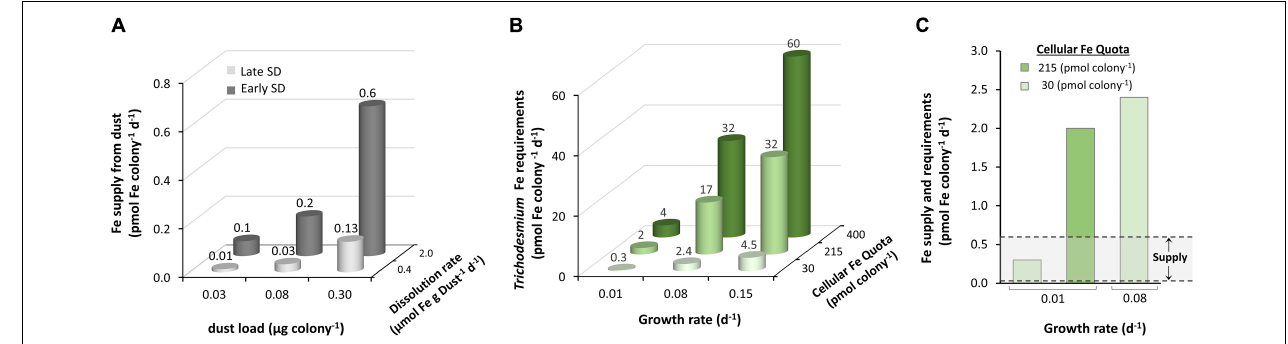
FIGURE 8 | Trichodesmium’s Fe demand versus Fe supply from dust. (A) The supply of dissolved Fe from dust particles, associated with Trichodesmium colonies, was calculated for the range of observed dust loads (see section “Estimation of Dust Loads on Trichodesmium Colonies”), combined with dissolution rates measured in late and early SD, with 9 µ M and 3 µ M DFOB, respectively. (B) Fe demand of Trichodesmium colonies was calculated for a range of cellular Fe quotas and growth rates, reported in the literature (more details in Supplementary Table S1 ). (C) Comparing the lower end of Fe demands that are suitable for Fe-limited Trichodesmium (green bars; 0.3 – 2.4 pmol Fe colony − 1 d − 1 ) to the range of Fe supply from dust (gray zone; 0.01–0.6 pmol Fe colony − 1 d − 1 ) demonstrates that dust can fully supply the demand of only the slowest growing, most Fe limited colonies. In other scenarios, the estimated Fe supply only meets a fraction of the